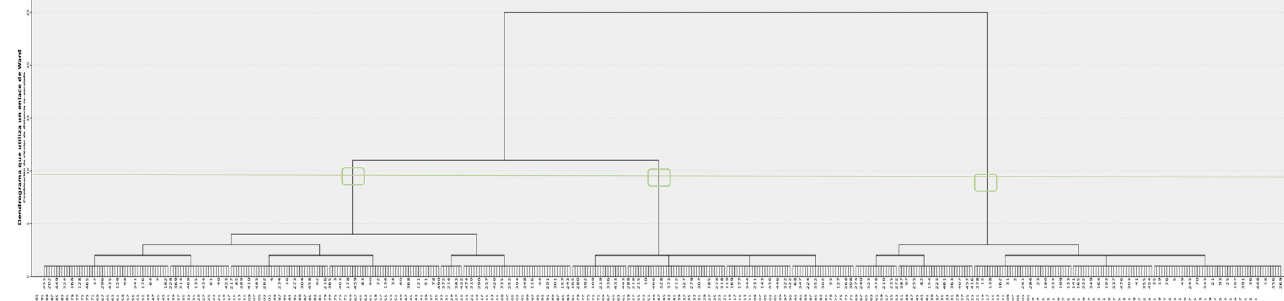
Figure 1. Cluster analysis dendrogram.